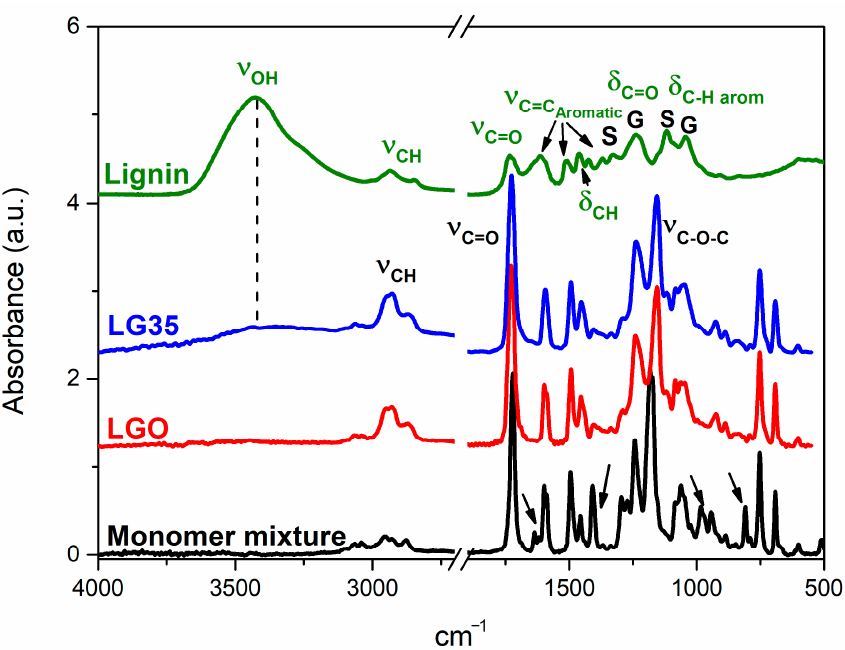
Figure 7. FTIR spectra of pTSA-PANI, pristine acrylic (LG0) and the composites LG0PANI5 and LG1PANI5.